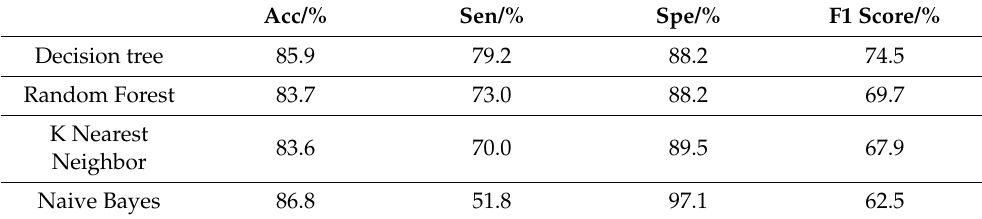
Table 3. Comparison of severe OSA screening results with different classifiers based on OP_IBS.